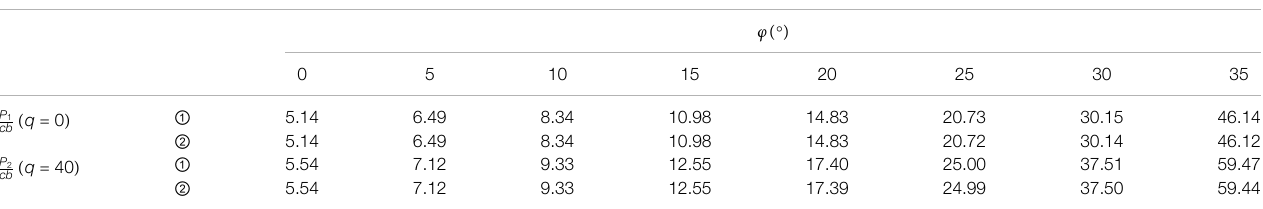
TABLE 1 | Comparisons of ultimate bearing capacity and characteristic parameters under different internal friction angles.